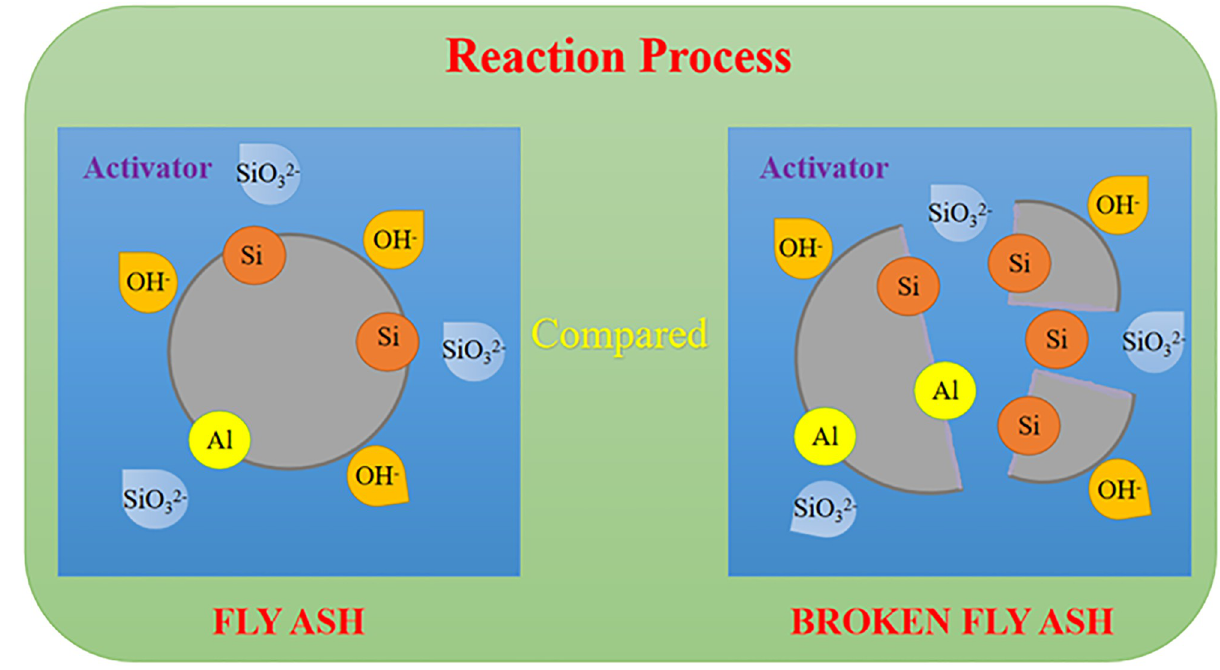
Fig 19. Reaction process comparison